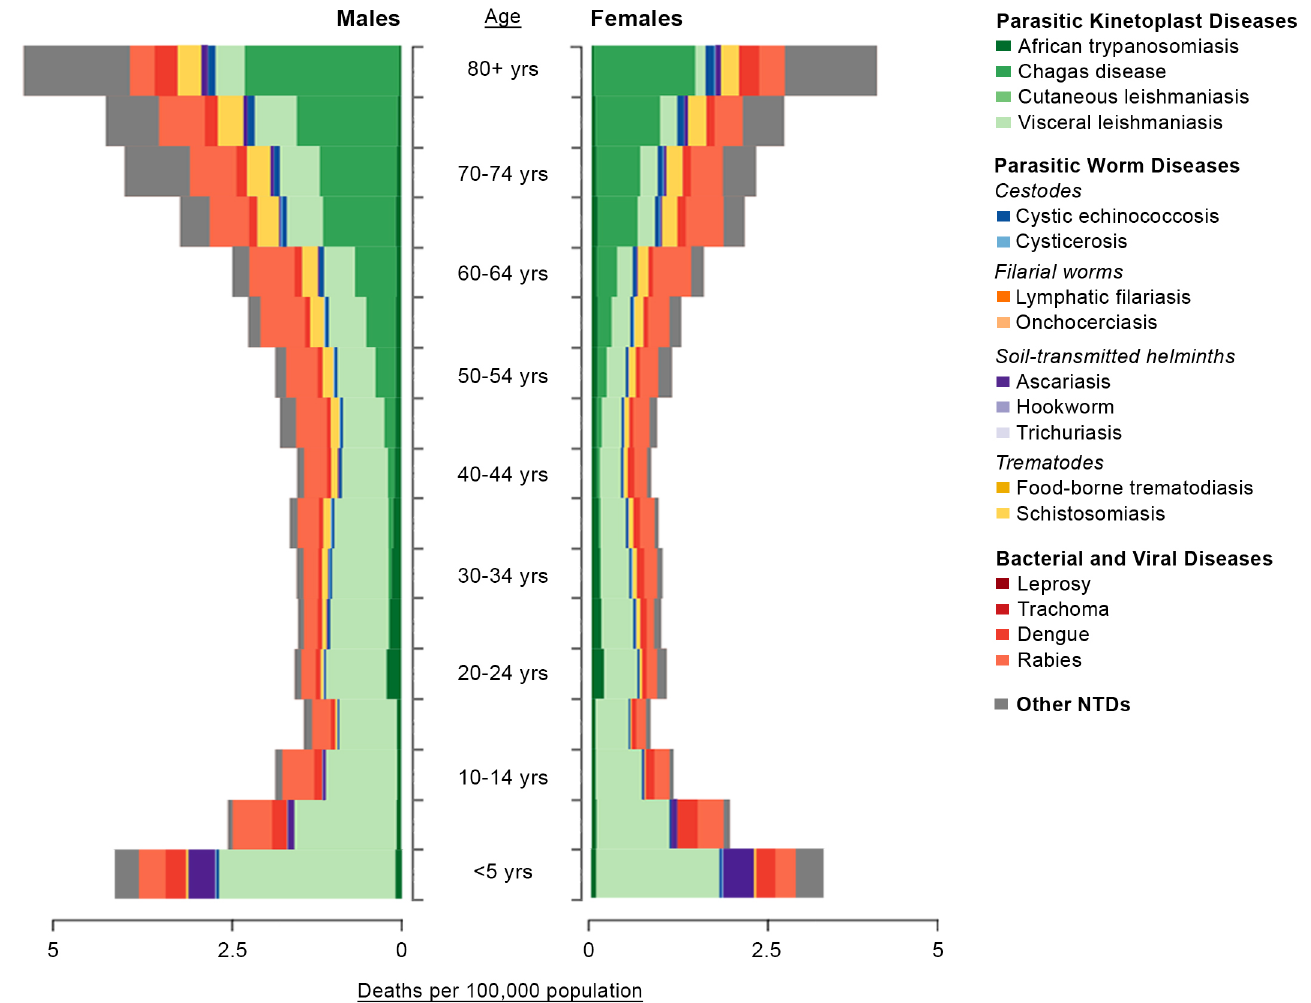
Fig 5. Deaths per 100,000population by age and sex in 2013. The data used to generatethis figure are also availableon the Institute for Health Metrics and Evaluation(IHME)